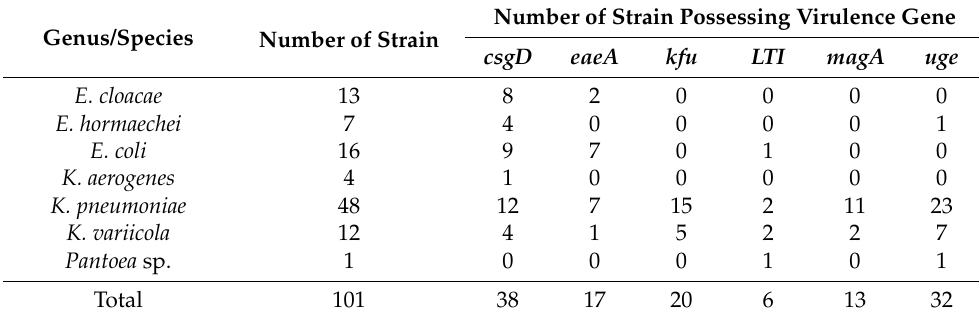
Table 5. Number of enterobacterial strain in each genus or species that possessed virulence gene. Genus/Species